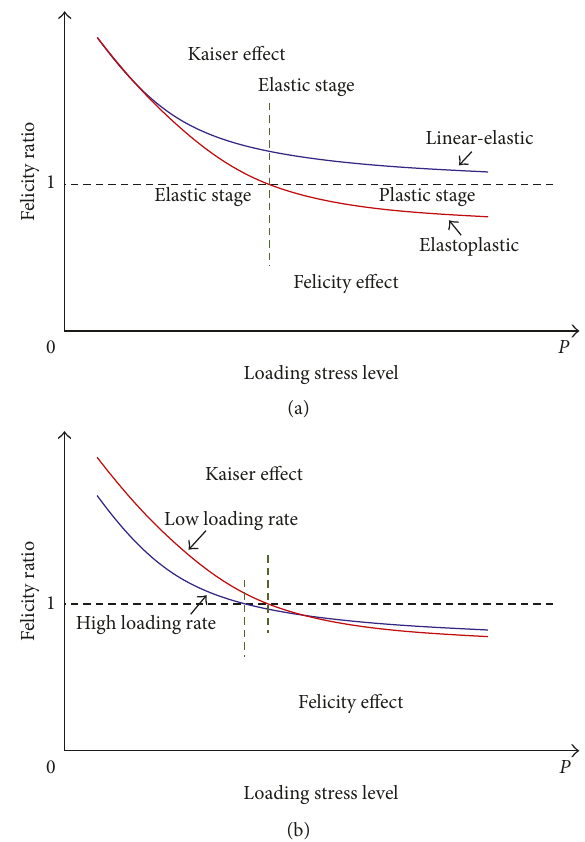
Figure 12: Evolution of the rock Felicity effect under uniaxial cyclic loading-unloading compression conditions. (a) AE Felicity effect in linear-elastic model and elastic-plastic model; (b) influences of AE Felicity effect under low and high loading rates.